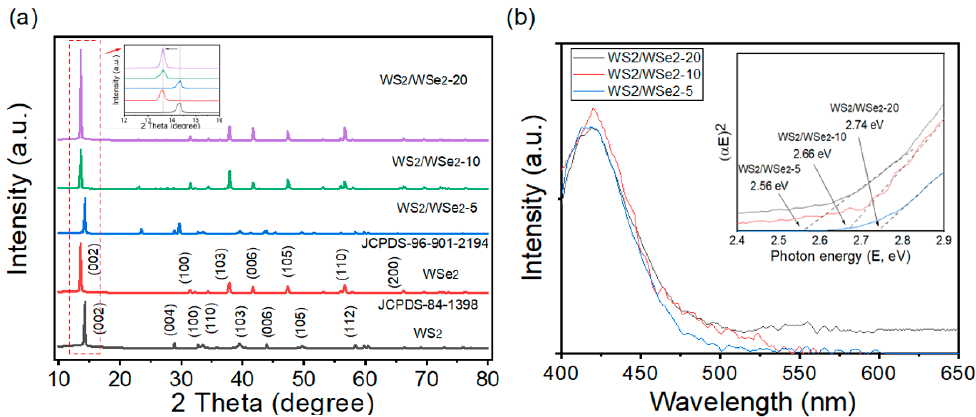
Figure 1. ( a ) XRD patterns of the as-prepared samples; ( b ) UV–vis spectra of WS 2 /WSe 2 -5, WS 2 /WSe 2 -10, and WS 2 /WSe 2 -20 samples; plots of ( α h υ ) 2 versus h υ for the bandgap energies of the photocatalysts in the inset.